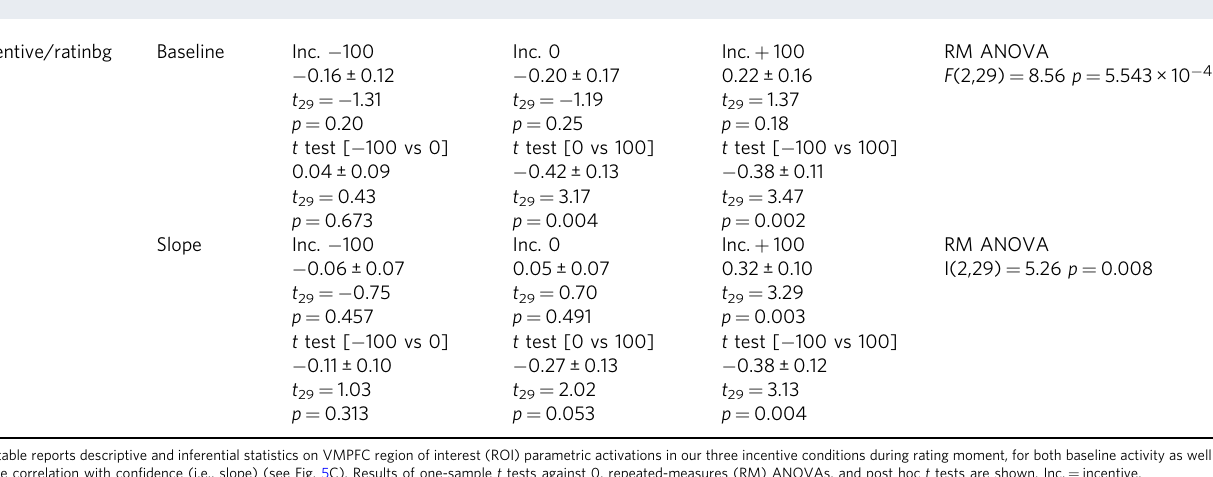
Table 3 Comparison of ventromedial prefrontal cortex (VMPFC) activity at rating moment ( t values), as a function of incentive condition.